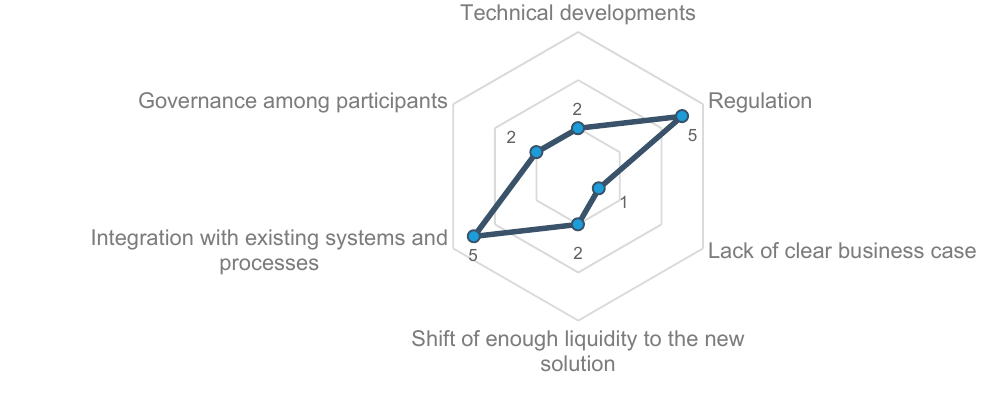
Figure 15. Challenges for post-trade processes.